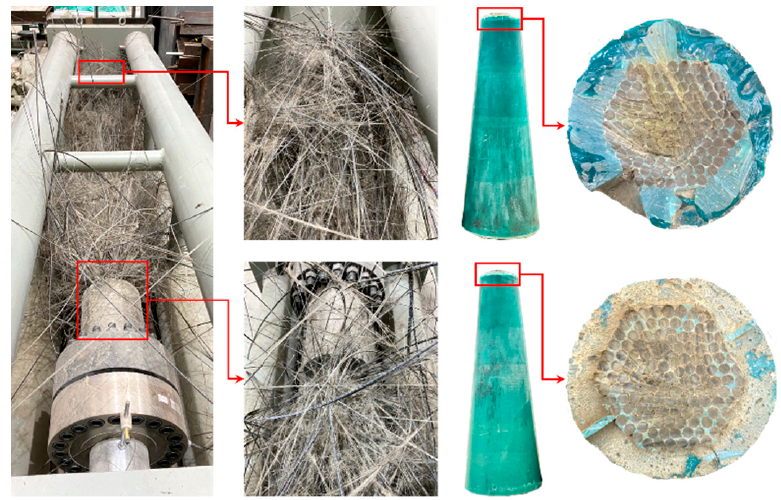
Figure 12. Failure mode of the CAS.